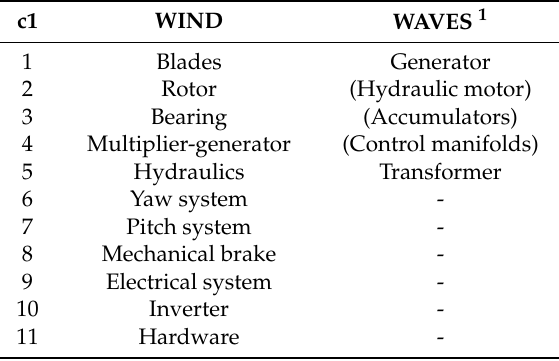
Table 1. Components of the